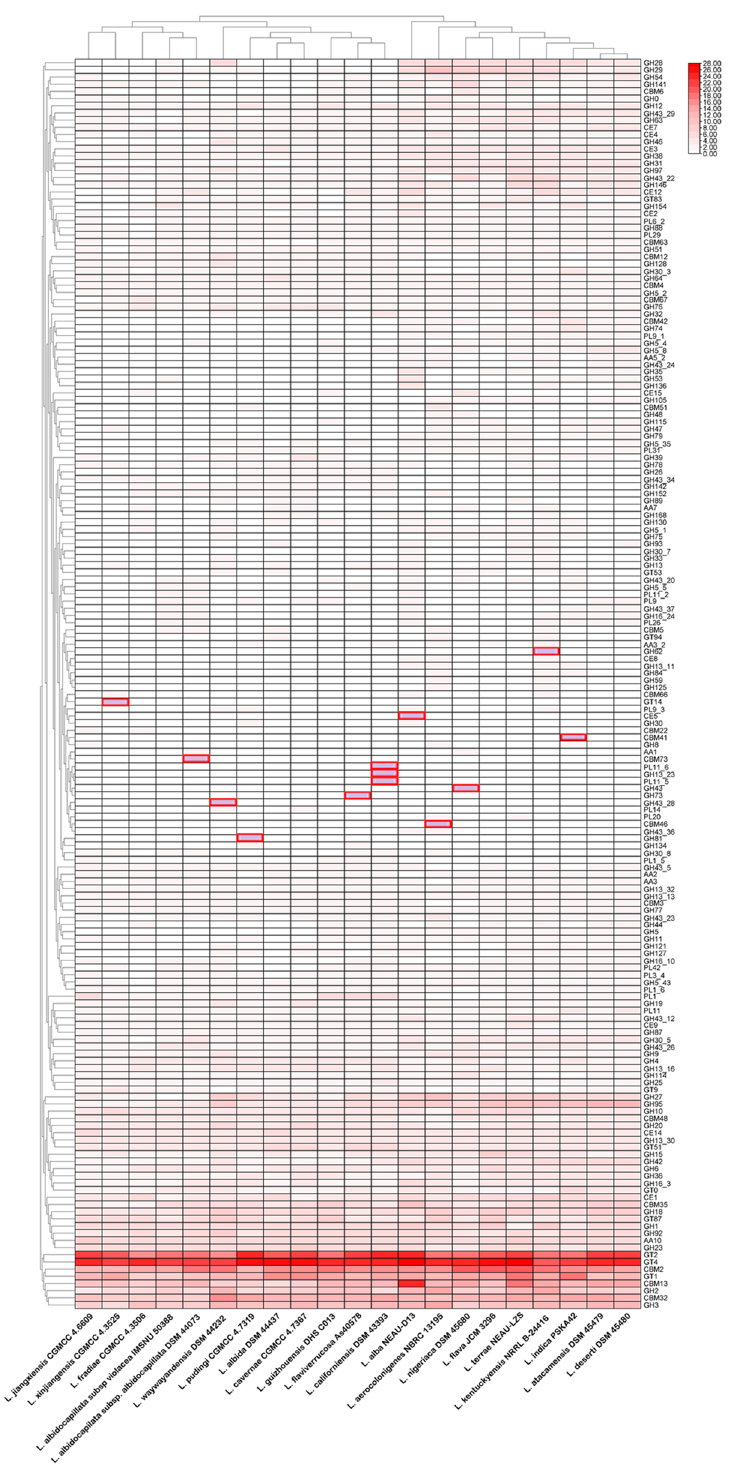
Figure 12. Heat map represents the abundance of the CAZymes present in Lentzea genome. The red color intensity is proportional to the abundance of the genes for CAZymes. Red box = unique